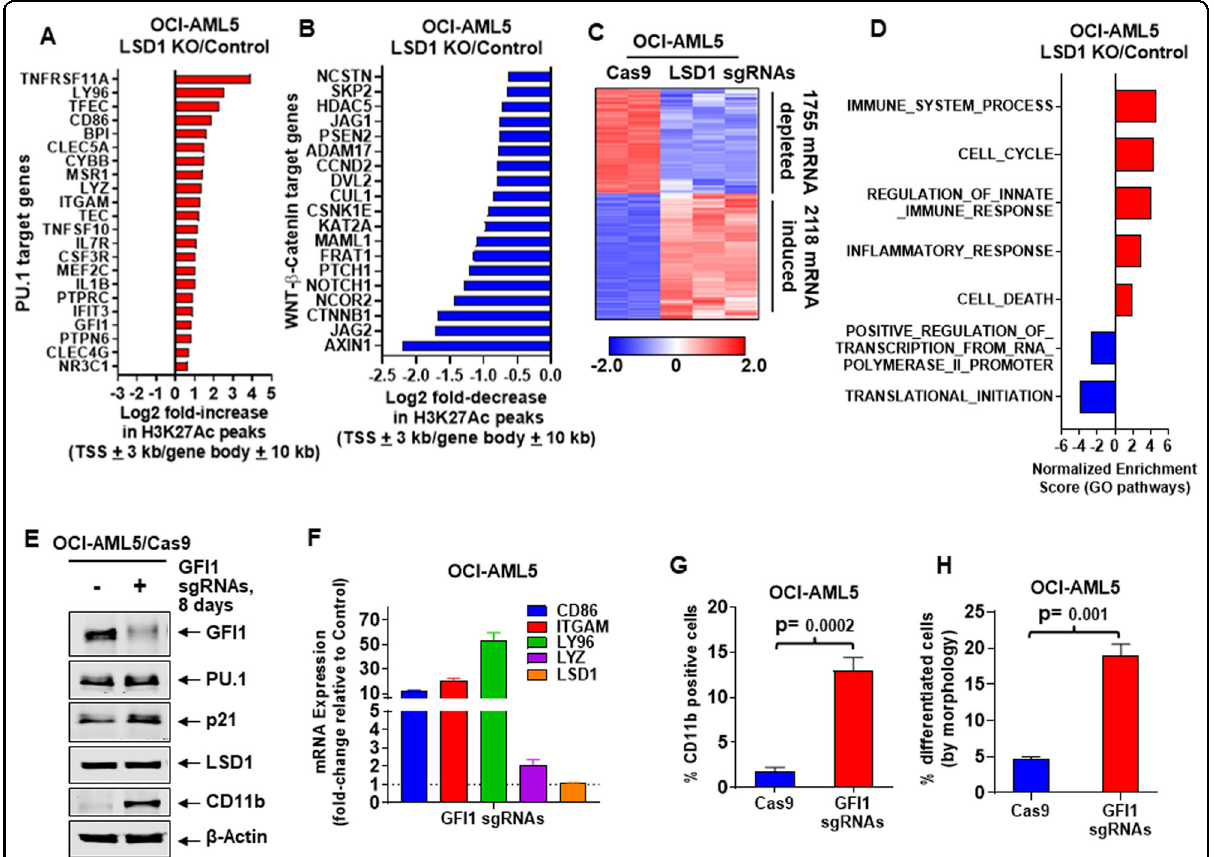
Fig. 2 Knockout of LSD1 alters chromatin accessibility, augments H3K27Ac occupancy on PU.1 target and WNT- β -Catenin target genes, and knockout of GFI1 induces myeloid differentiation genes, LY96 and ITGAM (CD11b) and morphologic differentiation of AML cells. A Log2 fold-change in H3K27Ac ChIP-Seq peaks (TSS + 3 kb or gene body + 10 kb) for PU.1 target genes (from the MSigDB database) in LSD1 knockout compared to Cas9-only-expressing OCI-AML5 cells. B Log2 fold-change in H3K27Ac ChIP-Seq peaks (TSS + 3 kb or gene body + 10 kb) in WNT- β -Catenin target genes (from HALLMARK datasets in the MSigDB database) in LSD1 knockout compared to Cas9-only-expressing OCI-AML5 cells. C RNA-Seq analysis was performed on OCI-AML5 LSD1 knockout (biologic triplicates) and Cas9-only-expressing (biologic duplicates) cells 8 days post- transduction. Heat map shows the number of mRNAs depleted or induced> 1.25-fold and p -value < 0.05 in the LSD1 knockout versus Cas9-only- expressing cells. D Gene set enrichment analysis was performed with RNA expression changes in OCI-AML5 LSD1-KO cells compared to GO pathways. The q -values are < 0.1 in all comparisons. E Representative immunoblot analysis of OCI-AML5 Cas9-expressing cells transduced with